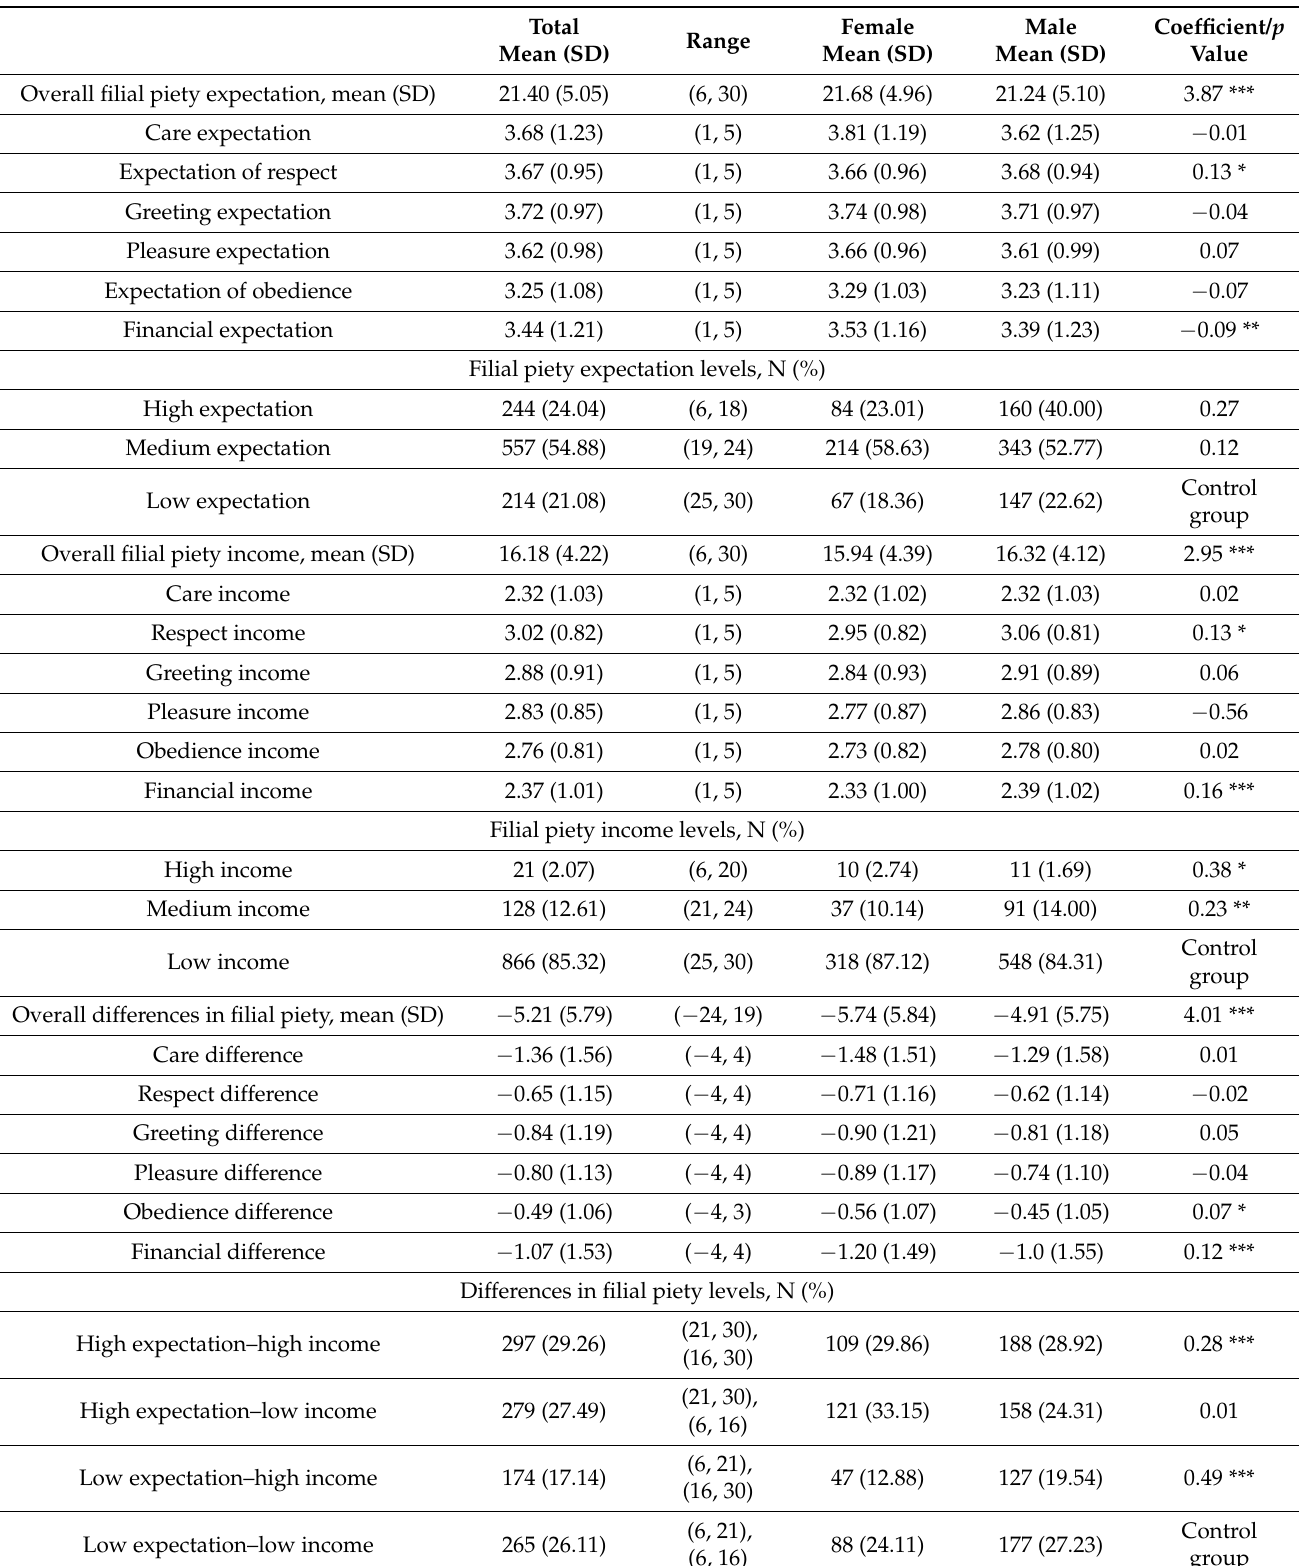
Table 2. Filial piety expectation, filial piety income and differences in filial piety among rural empty-nest